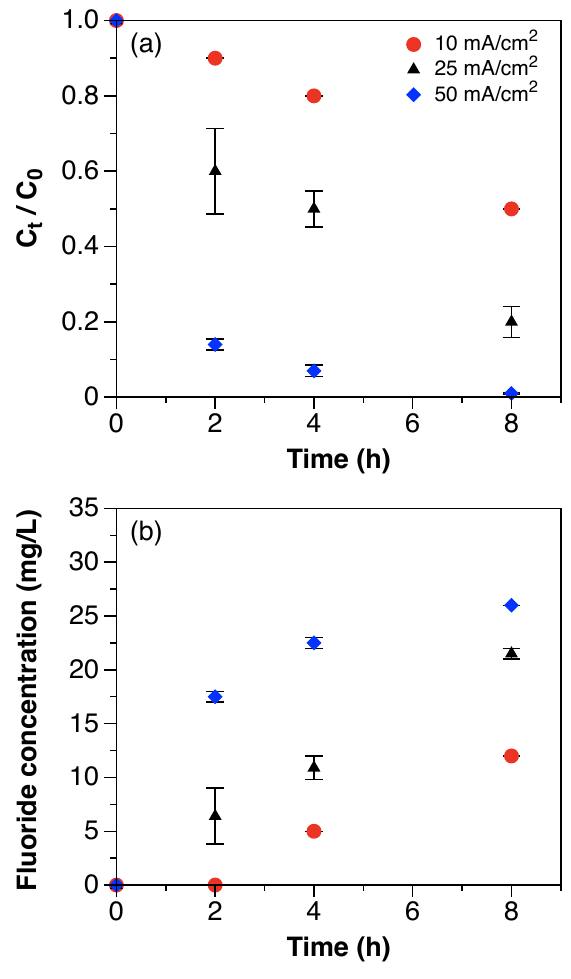
Figure 1. ( a ) Decrease in total PFAAs concentration and ( b ) fluoride generation over time for the electrochemical oxidation of a synthetic spent regenerant solution with 10, 25, and 50 mA/cm 2 . Error bars represent the standard deviation of